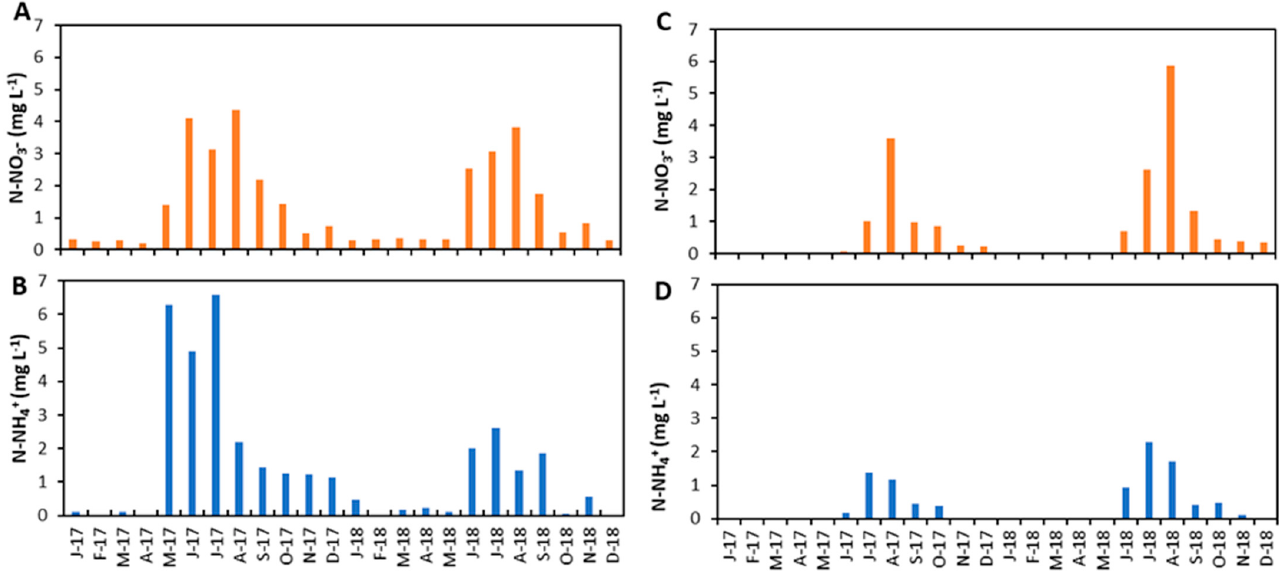
Figure 10. Monthly stream nitrate and ammonium concentrations (2017 to 2018). ( A , B ) are for Dangishta, and ( C , D ) are for Robit Bata watershed .